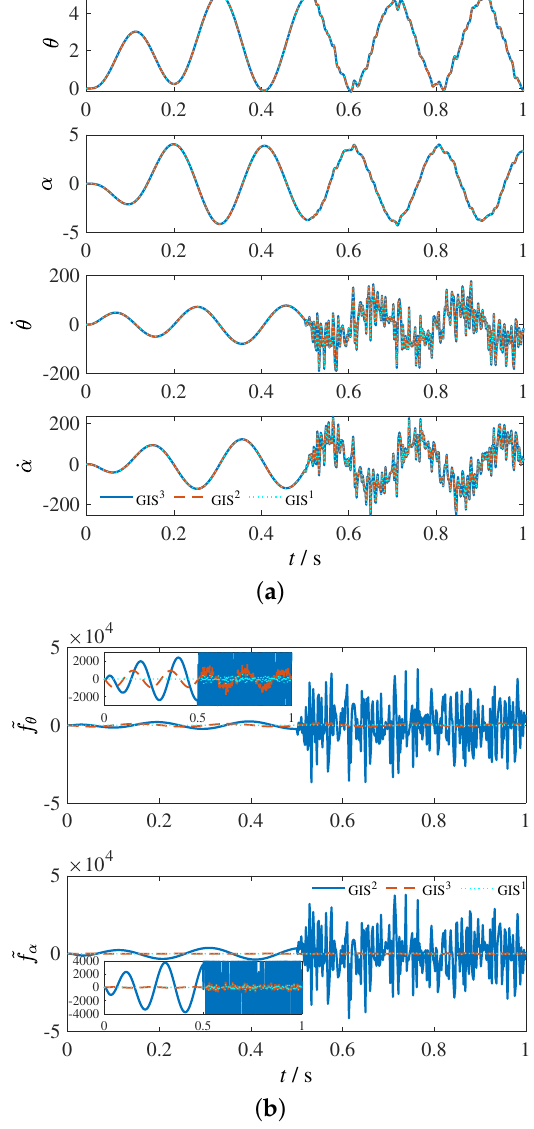
Figure 6. Estimated states of three types of GIS: ( a ) derivatives; ( b )